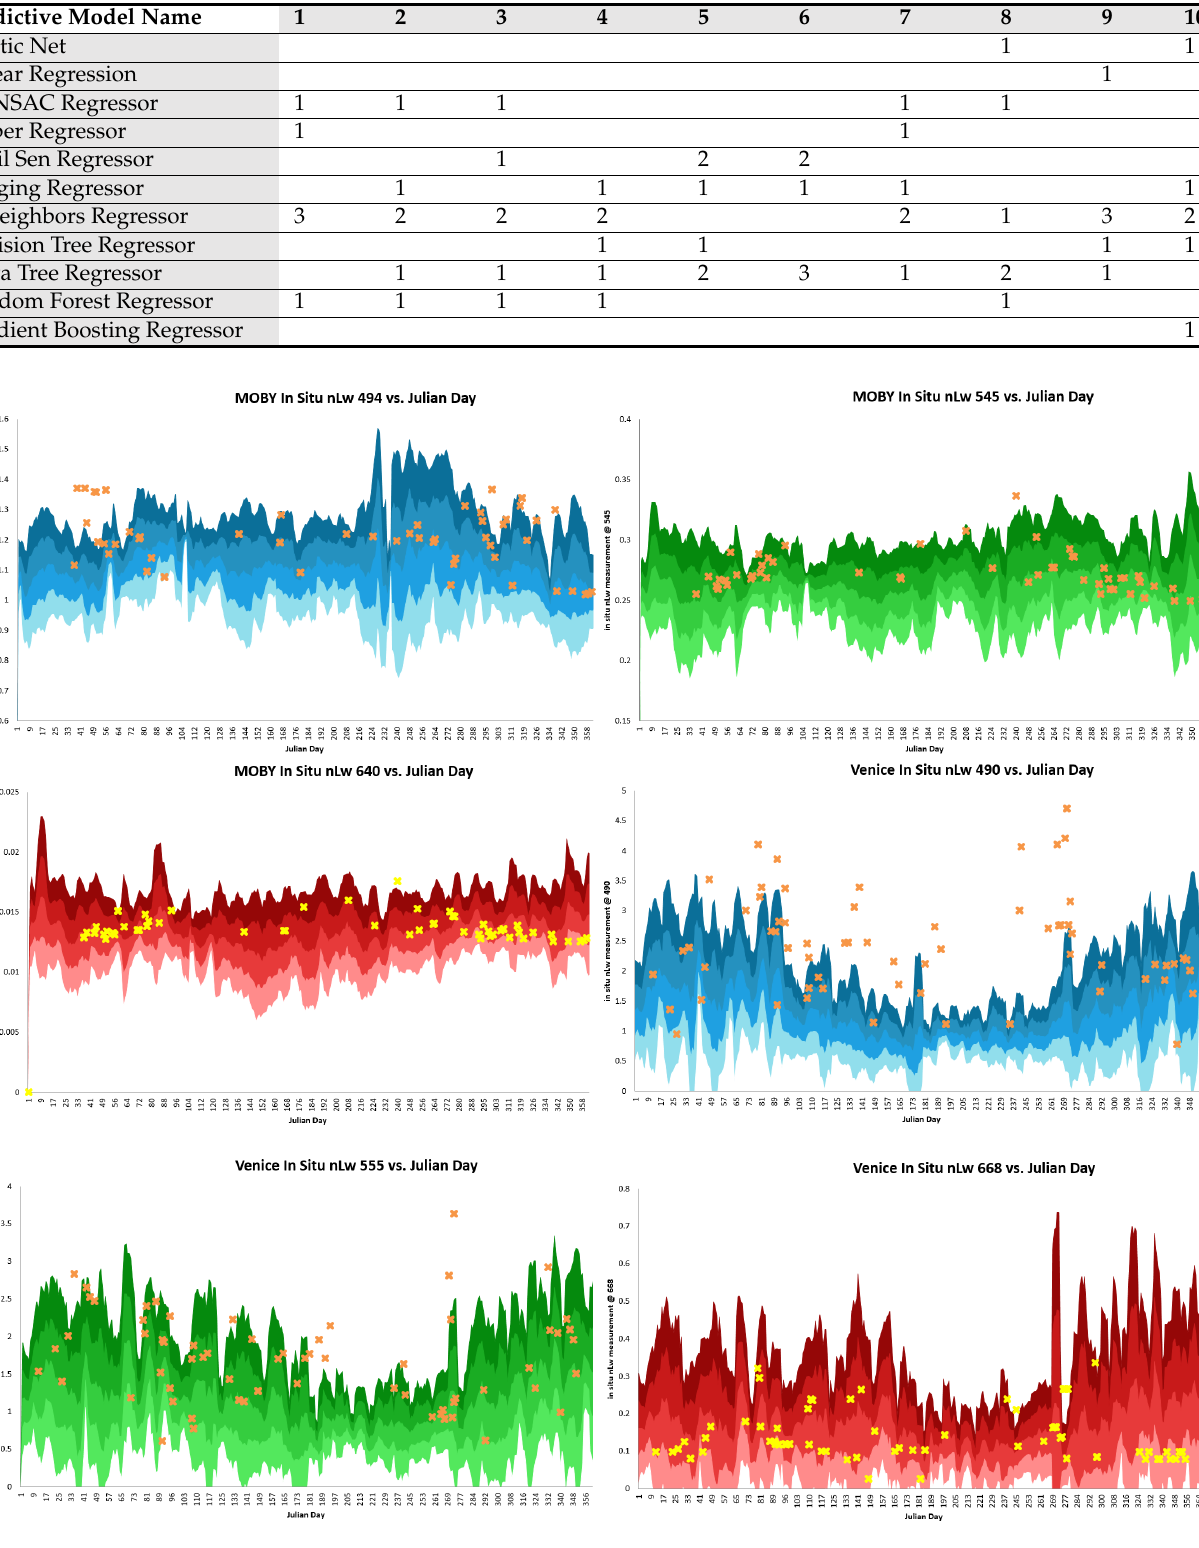
Figure 8. MOBY and Venice AERONET-OC in situ nLw climatologies with Planet nanosatellite nLw predictions. Top left : MOBY in situ nLw_494. Top right : MOBY in situ nLw_545. Middle left : MOBY in situ nLw_635/644. Middle right : Venice AERONET-OC in situ nLw_490. Bottom left : Venice AERONET-OC in situ nLw_555. Bottom right : Venice AERONET-OC in situ nLw_668. The orange ‘x’ indicates a nanosatellite nLw predicted value. For the MOBY location, the majority of the blue (71%), green (92%), and red (96%) nanosatellite predictions fall within two standard deviations of the in situ mean for that corresponding day. There are some seasonal biases for the nLw_494 predictions, where the values tend to be elevated in the winter months. For the Venice location, the majority of the green (71%) and red (95%) nanosatellite nLw predictions fall within two standard deviations of the in situ mean for that corresponding day, but the nLw blue (49%; 494 nm nanosatellite; 490 nm in situ) predictions are routinely overestimated, especially in the non-winter months. This is the opposite bias we observed at the MOBY location, poten- tially indicating that a secondary correction can be applied to these datasets to adjust the nLw values more towards observations. Figures 9 and 10 plot the nLw model predictions vs. in situ nLw values for both the MOBY and Venice AERONET-OC study areas. Matchups that likely fall outside of reality (beyond two standard deviations from the mean), mostly due to pixel contamination that is currently unfiltered, can be filtered from the final nLw predictions. The nanosatellite nLw predictions at the MOBY site had higher Pearson R correlation coefficients in the blue (0.22) and green (0.36) than in the red (0.08). A large factor in the inconsistencies observed